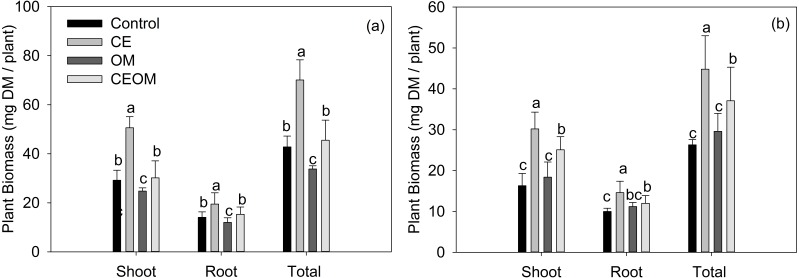
Shoot biomass, root biomass and total biomass of inoculated (A) and non-inoculated (B) lucerne under different soil amendment treatments: control, compost extract (CE), bio-organic manure (BOM) and compost extract + bio-organic manure (CEBOM). Bars represent the standard errors, n = 20.